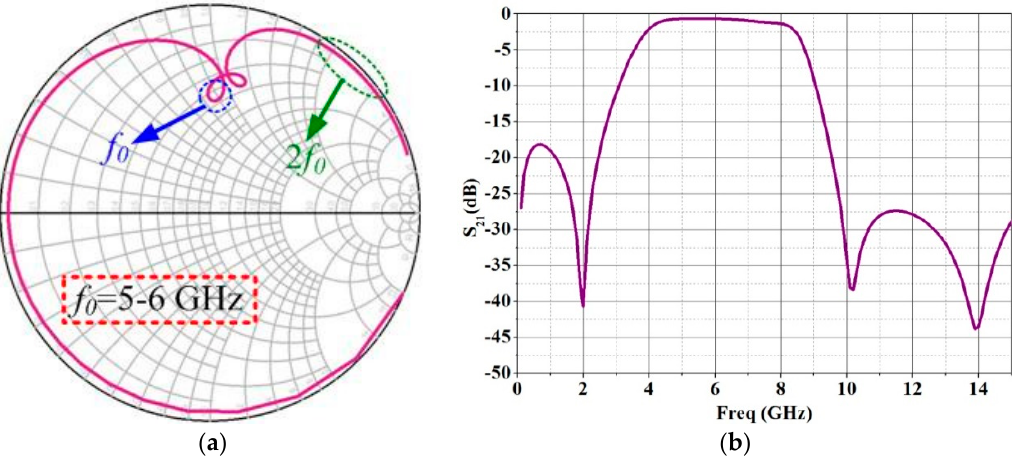
Figure 3. Simulation results of the proposed output matching network: ( a ) Input impedance of the proposed output matching network; ( b ) S 21 of the proposed output matching network.